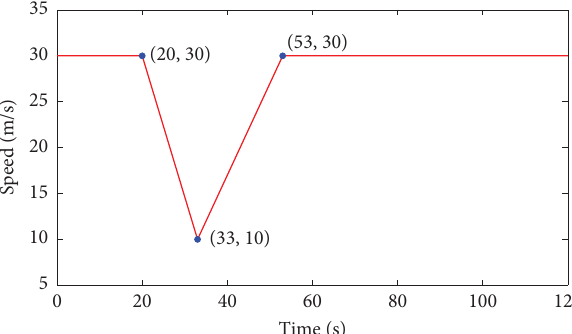
Figure 8: Changes in the speed of the leader